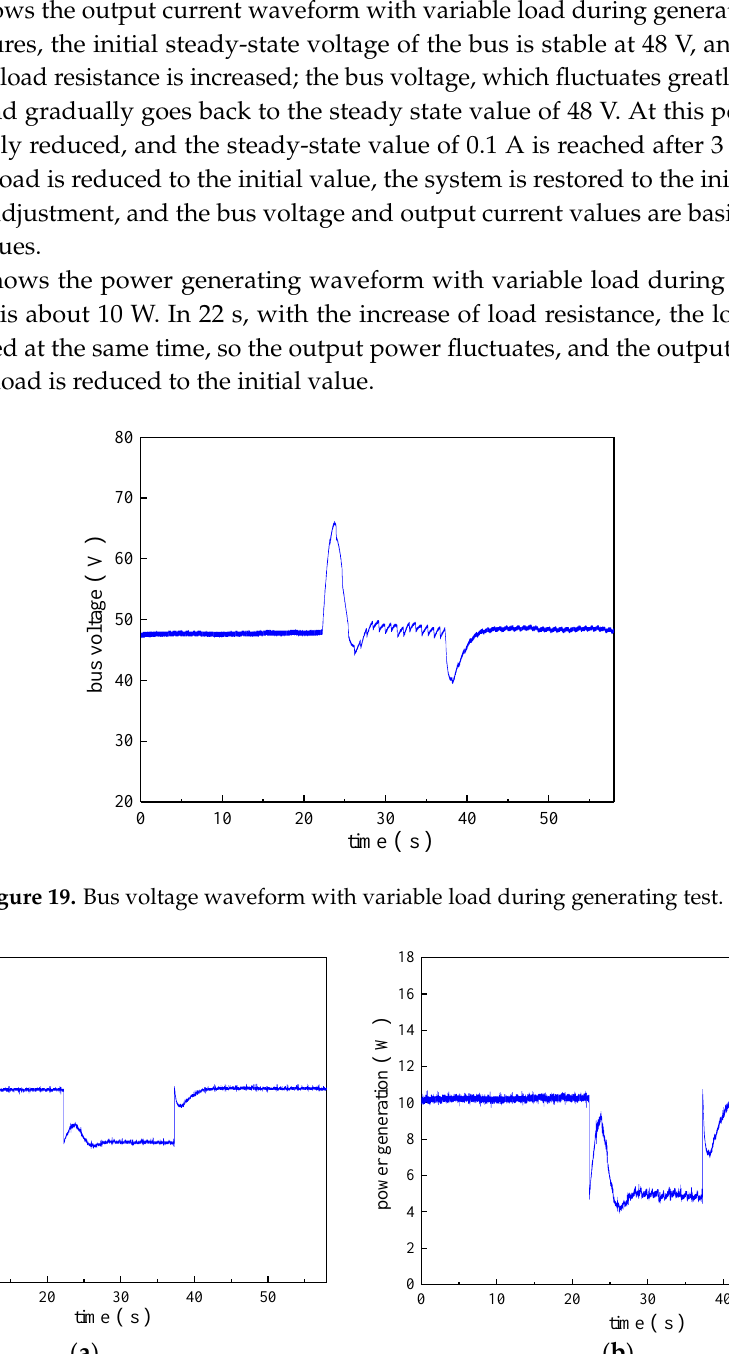
Figure 18. Piston displacement waveforms with variable load during generating test.